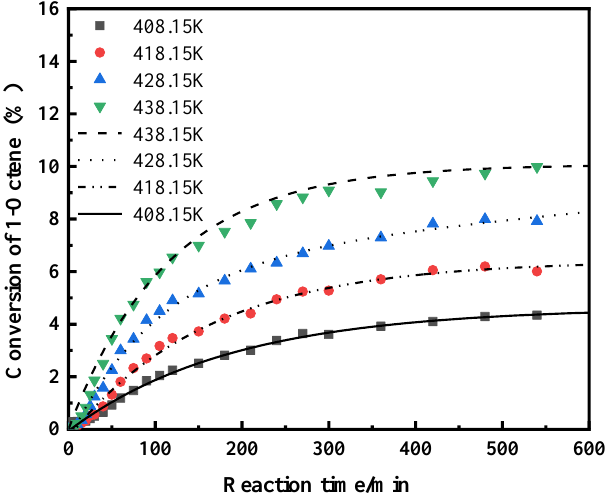
Figure 4. Effect of temperature on the reaction. Note: the dots in the figure are used to represent experimental values and the lines are calculated values.